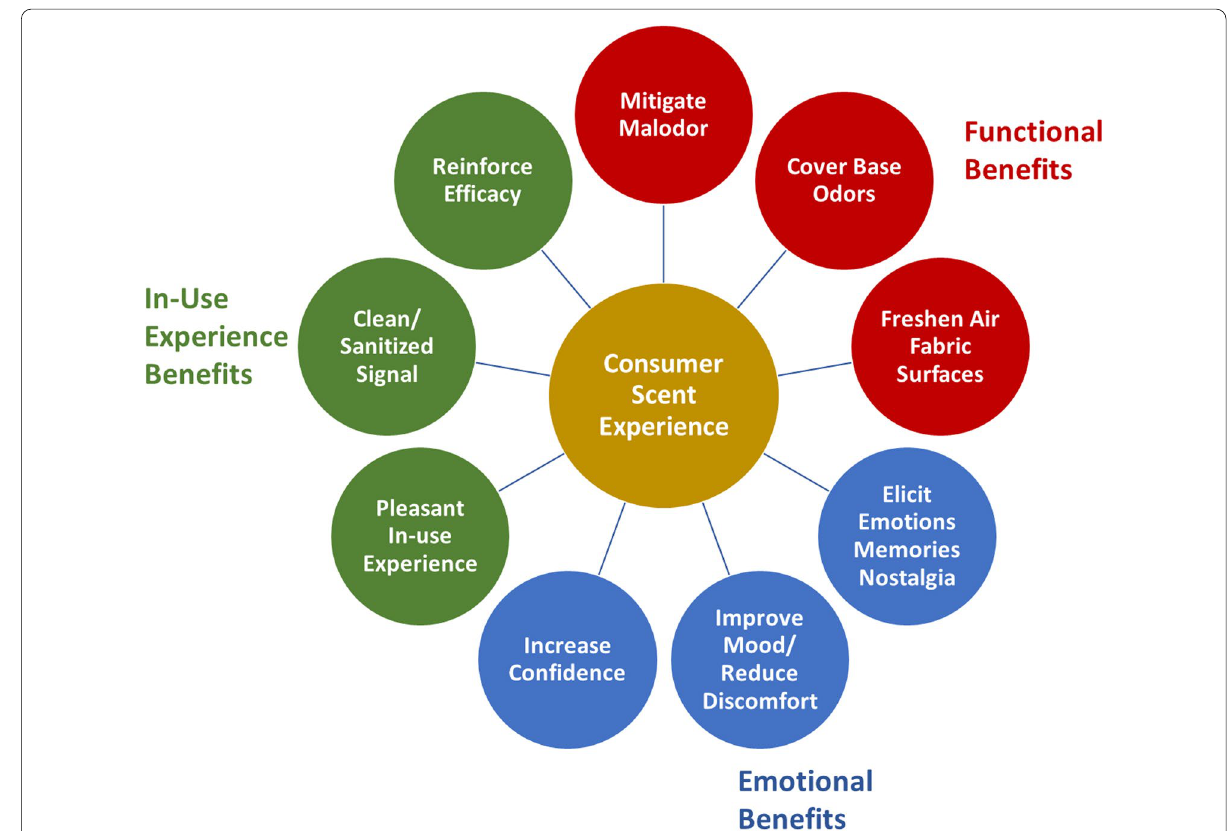
Fig. 1 Three-factor benefits framework for scent in household